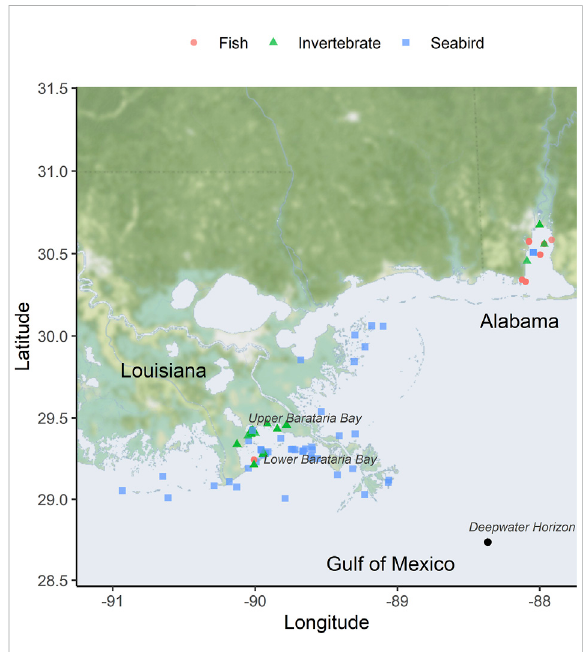
FIGURE 1 Study sampling locations in the northern Gulf of Mexico. Invertebrates, fi shes,andseabirdsaroundtheLouisianacoastwere collected in the aftermath of the 2010 Deepwater Horizon oil spill. Historic oyster samples were collected from the two locations in Barataria Bay by the Mussel Watch Program from 1986 to 2007. Upper Barataria Bay corresponds to Bayou St. Denis and Lower Barataria Bay corresponds to the Middle Bank. Alabama samples were collected by Showalter (2010) in 2008 and